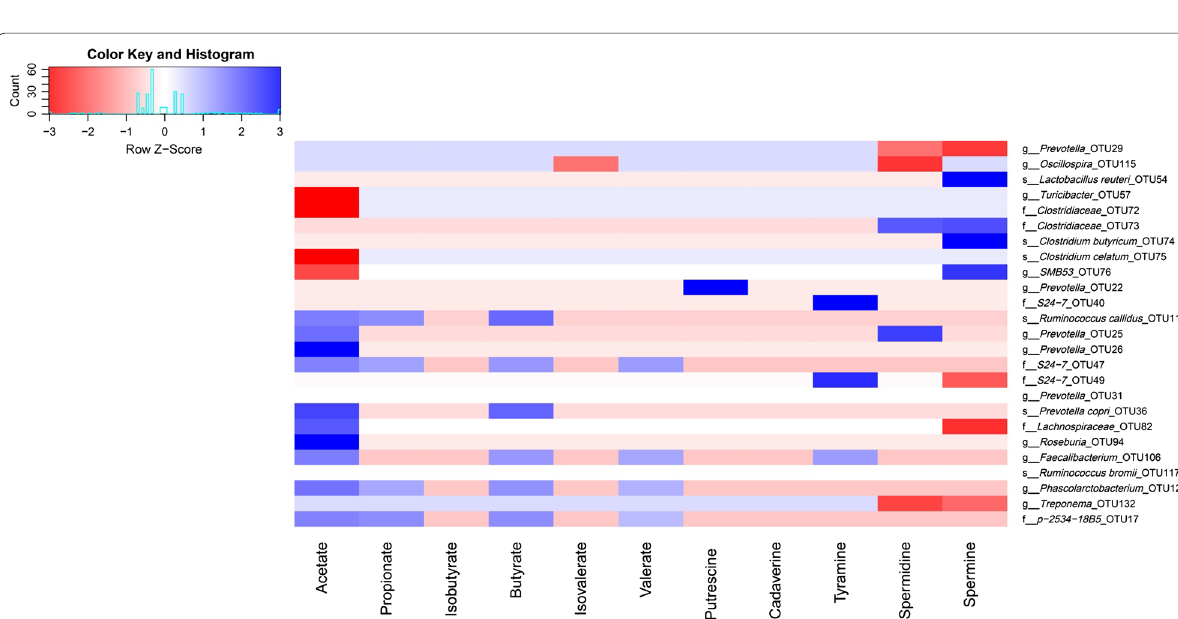
Fig. 5 The heatmap plot of spearman correlations between bacterial markers and SCFAs or bioamines. Only those correlations with P < 0.05 are